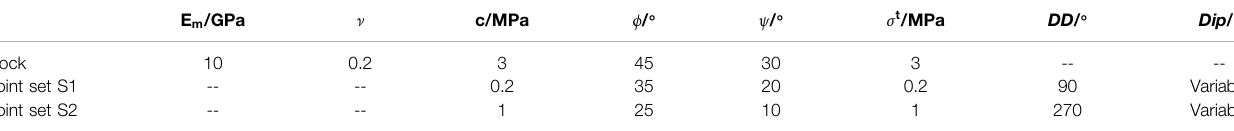
TABLE 1 | Material parameters for the triaxial compression